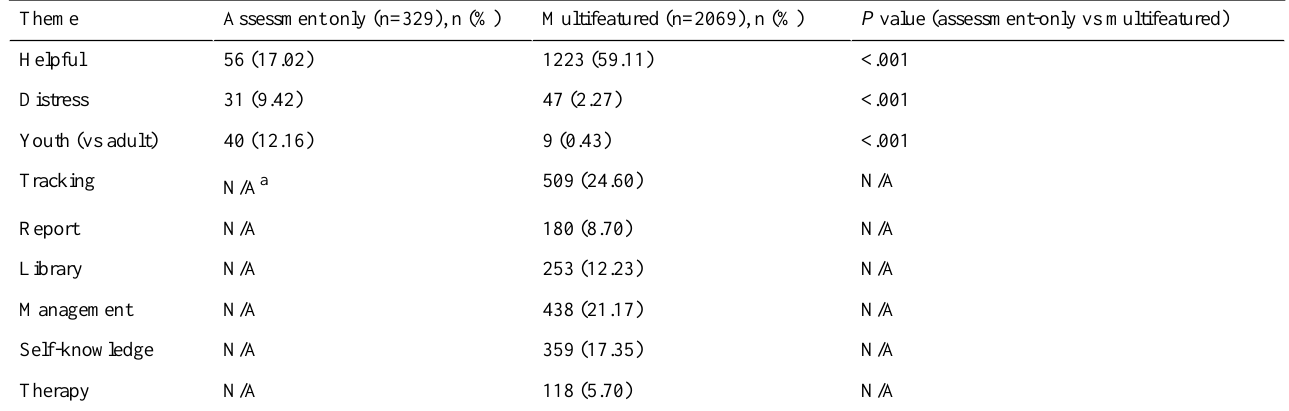
Table 3. Thematic coding results